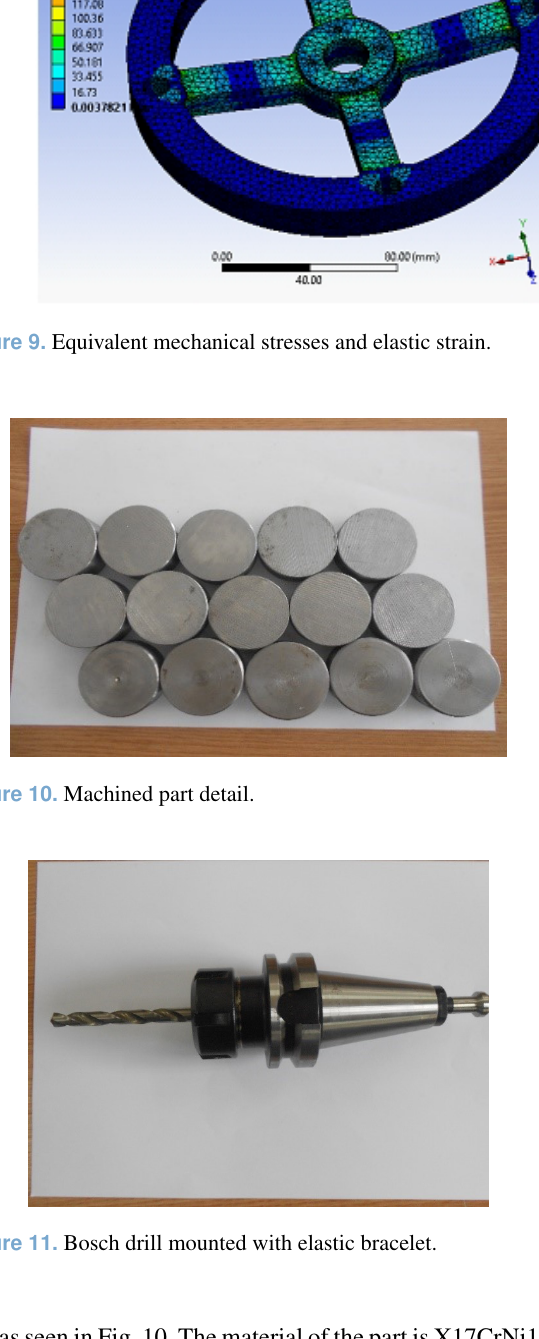
cut, as seen in Fig. 10. The material of the part is X17CrNi16- 2 stainless